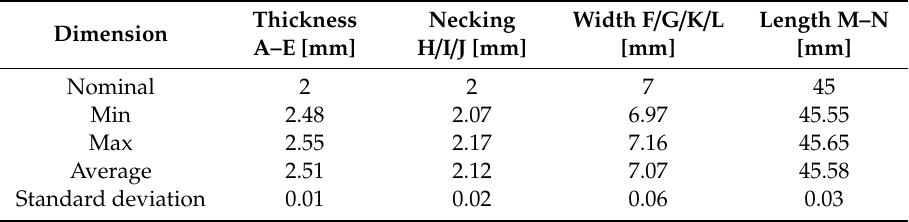
Table 3. Dimensional accuracy of samples for testing mechanical